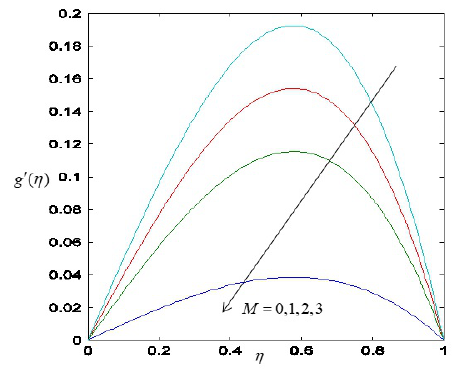
Fig. 6: Influence of g ′ ( η ) for various values of M